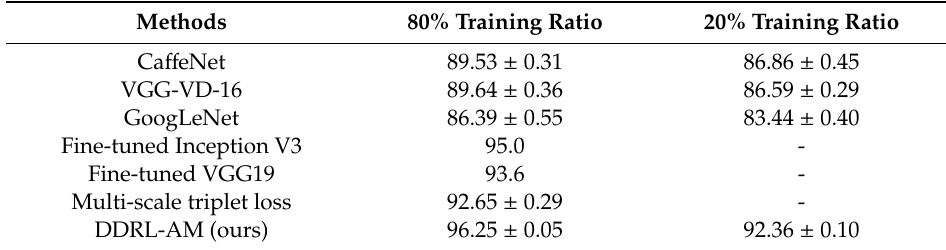
Table 4. Scene classification results (ac% ± std) using the AID dataset.